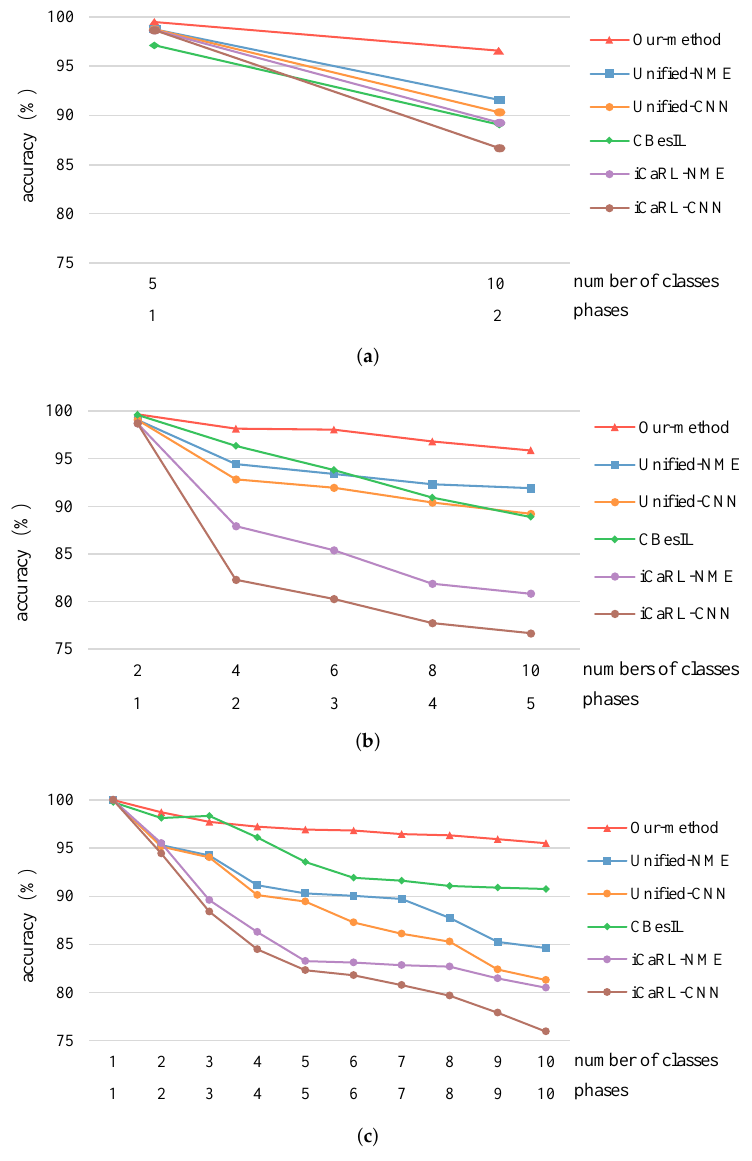
Figure 4. Target incremental recognition accuracy at different incremental phases and different classes per phase. ( a ) 2 phases, 5 classes per phase. ( b ) 5 phases, 2 classes per phase. ( c ) 10 phases, 1 class per